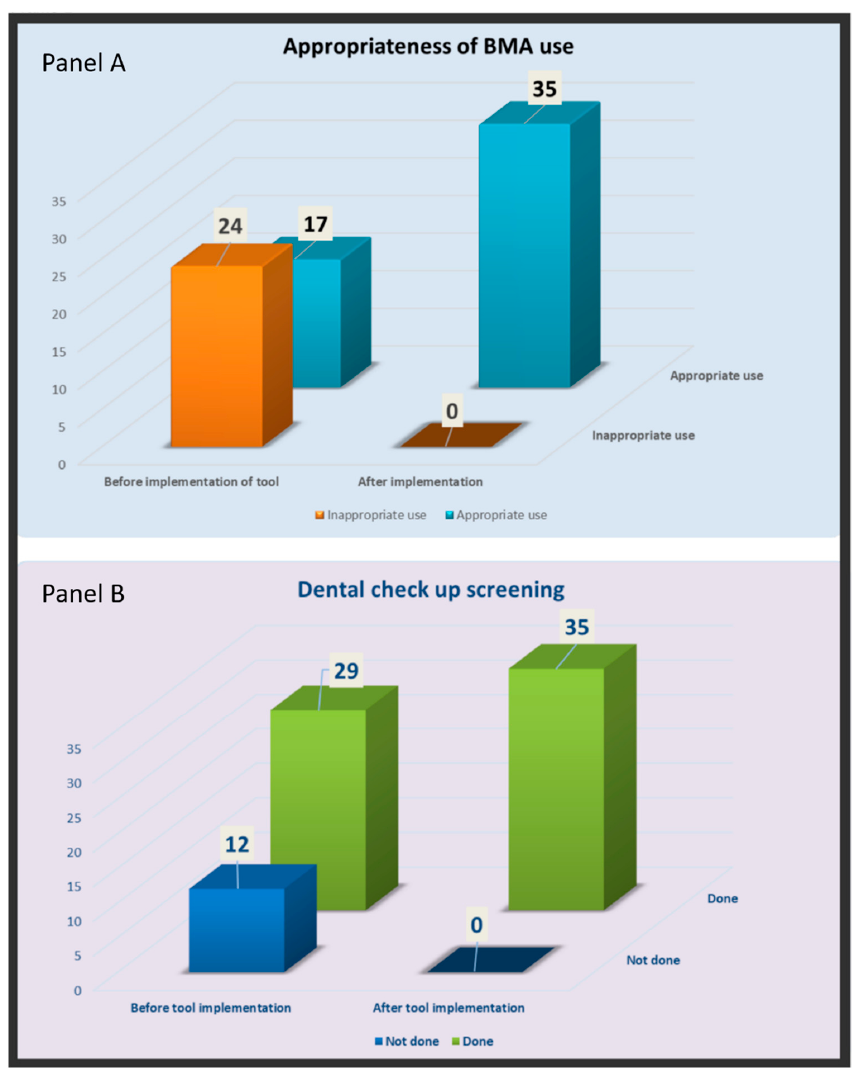
Figure 3. Comparing the change in the practice while prescribing BMA ( panel A ), and referral for dental screening ( panel B ) with the implementation of new algorithmic tool into Computerized Patient Record System.